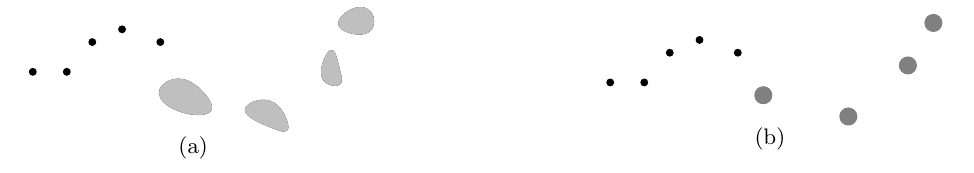
Figure 1 . (a) A system of 5 real elementary anyons and 4 gapped boundaries. Each gapped boundary can be transformed to a small hole as in (b), without a(cid:11)ecting the Hilbert space structure of the system. In this perspective, the Hilbert space consists of 5 elementary anyons and 4 composite anyons respectively identi(cid:12)ed as the 4 boundaries components with their topological